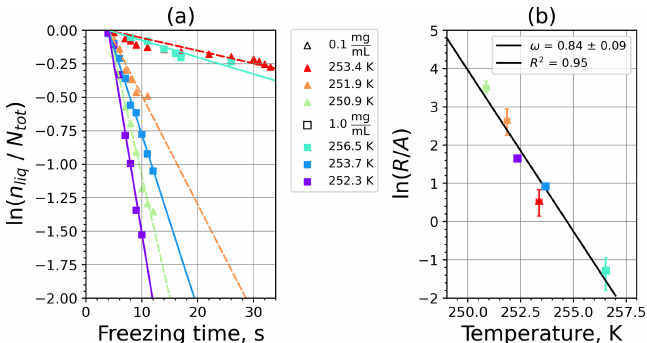
Figure A11. (a) The decrease in fraction of droplets which remained liquid with time at different temperatures in the isothermal experiments for Sahara dust at the M-WT. The colors correspond to different temperatures (particle concentrations of 5gL − 1 ). Typical error bars are depicted in Fig. 6. (b) Freezing rate of Sahara dust normalized to surface area as a function of temperature.